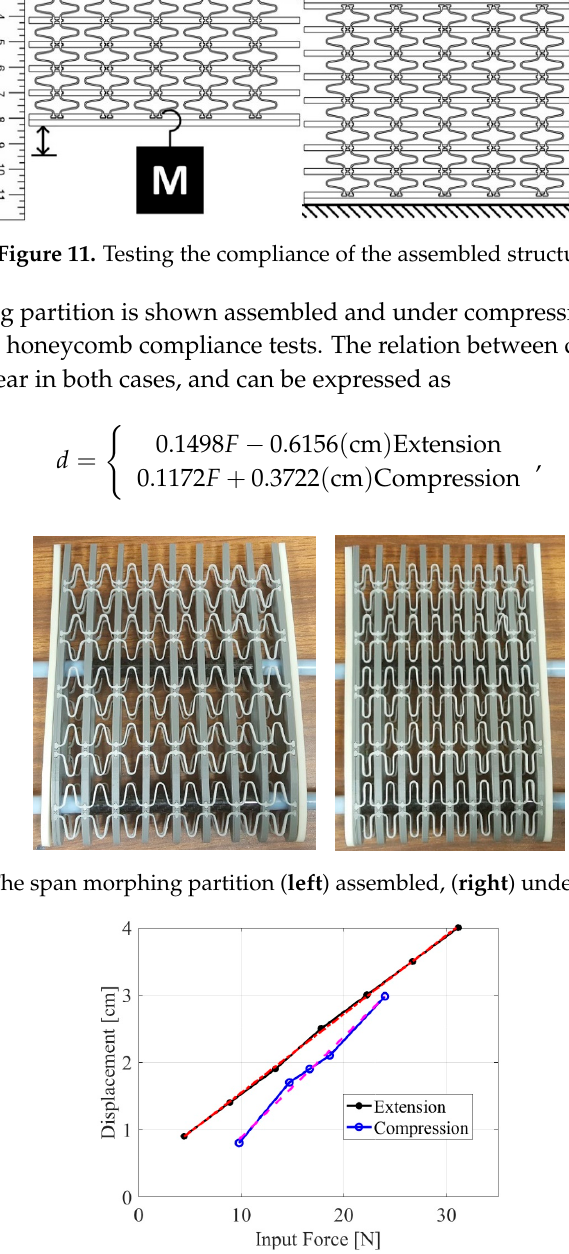
Figure 13. Honeycomb displacement vs. input force, in extension and compression tests.